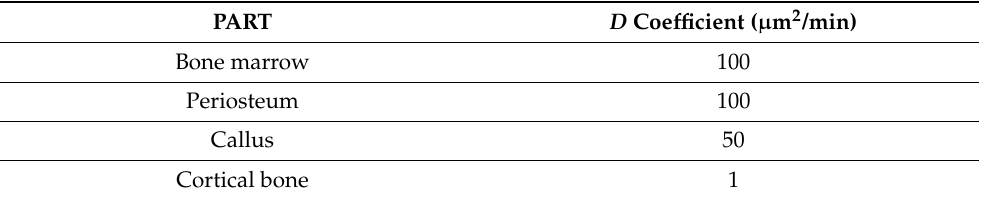
Table 1. Values of the diffusion coefficients inside the different regions of the bone. The values are constant throughout the corresponding regions.